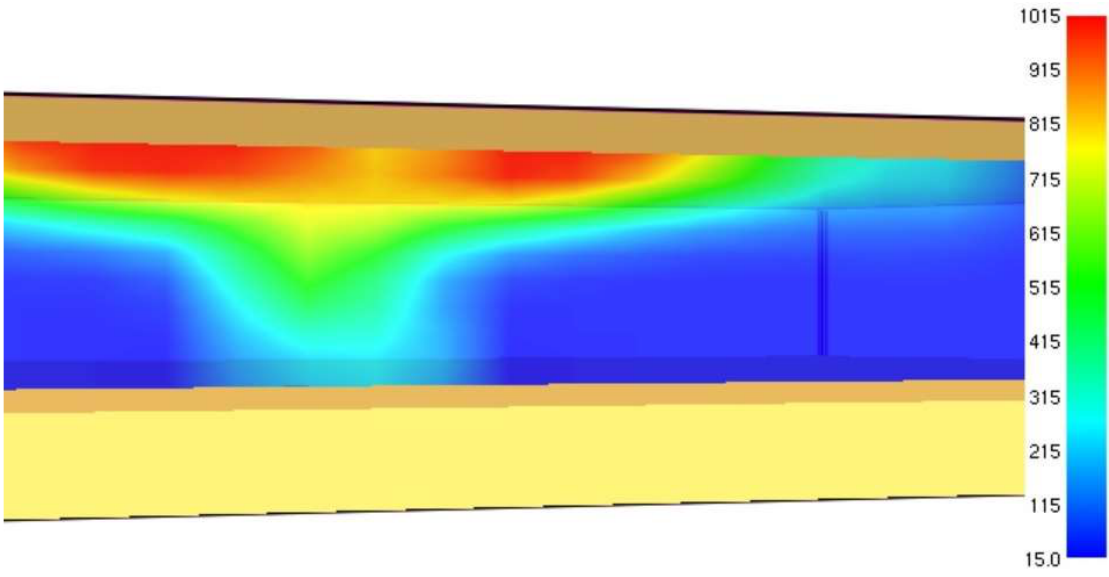
Figure 7. Temperature field (°C) of the Propane jet fire at t = 3.2 s.